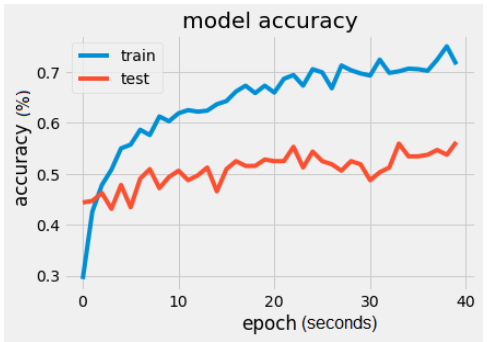
Figure 8. MobileNet model accuracy.